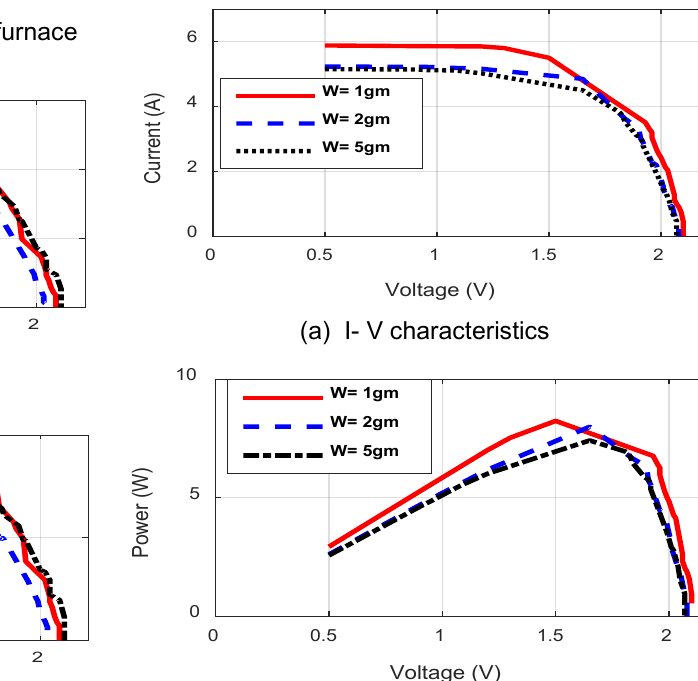
(a) I- V characteristics